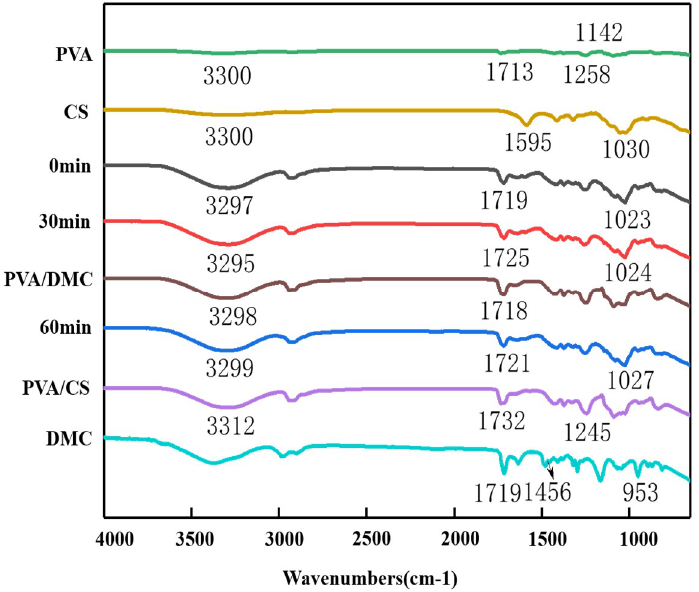
Figure 2. FTIR spectra of the PVA, CS, PVA/CS, PVA/DMC film (not processed with ultrasonication) and typical PVA/CS/DMC composite films with a concentration of 2% below different ultrasound times.